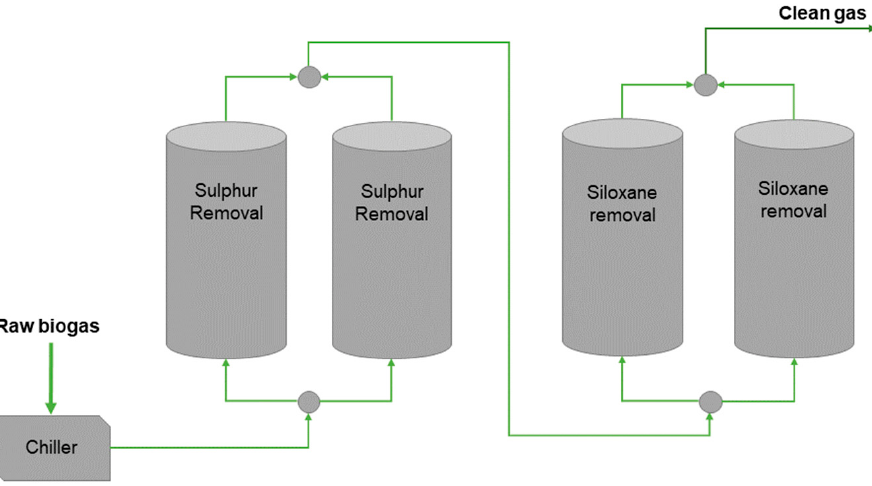
Figure 3. Biogas production and utilization plant layout of the DEMOSOFC site (Collegno, Italy). Adapted with permission from [70]; published by Elsevier, 2020.